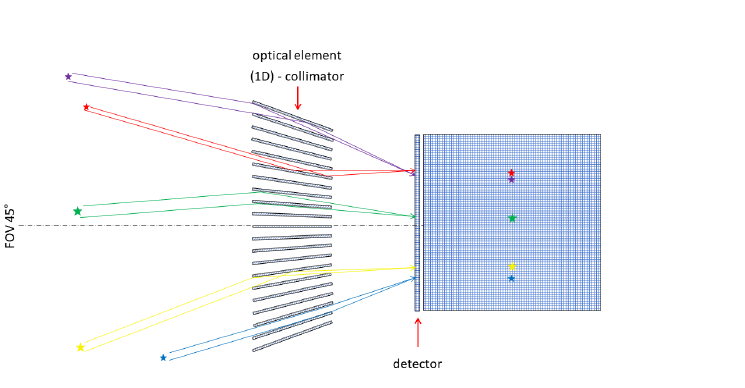
Figure 2. Focusing-collimating principle scheme of the X-ray/Gamma-ray optics-collimator. The imaging detector, provided by the pixel detector Timepix, is located closely behind in the focal-plane. The transmission and registration of three sources is illustrated along the lateral view ( left part ) and front side ( right part